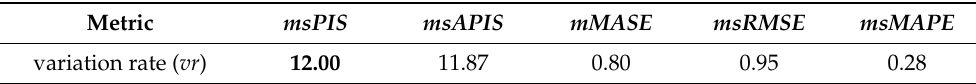
Table 3. Average variation rate of performance metrics for a variation in bias and fixed standard deviation of forecast